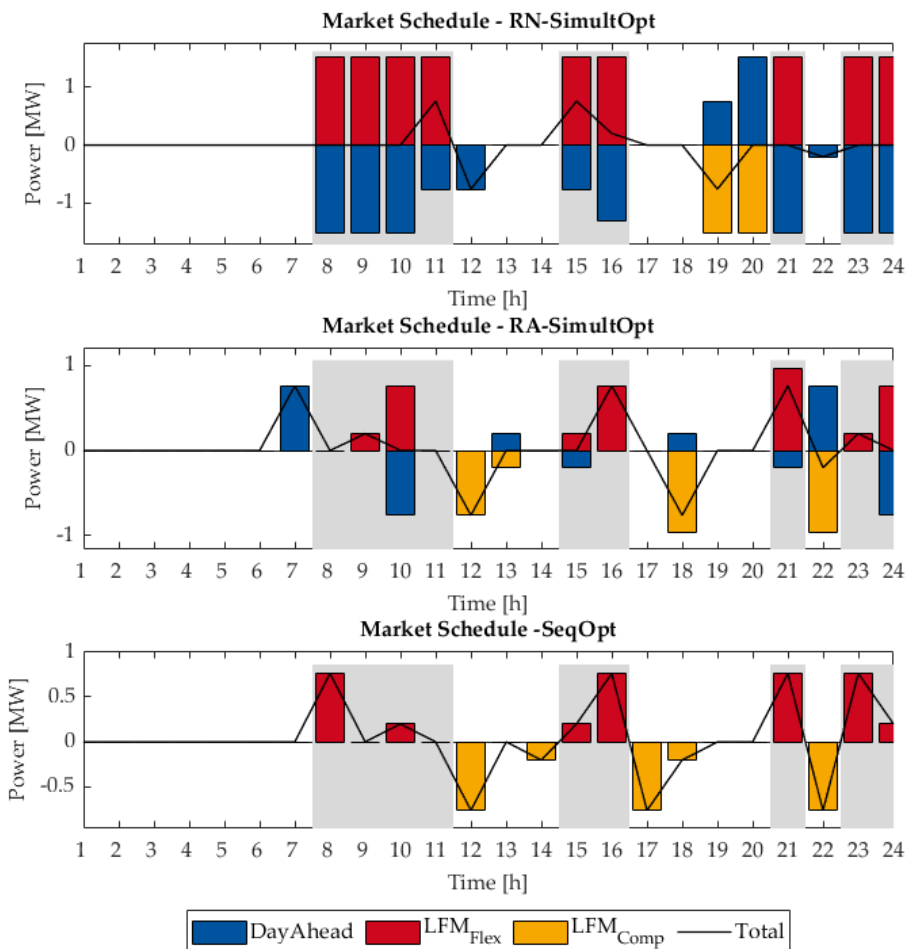
Figure 10. Market schedules of BSS for the three different operational planning modes (Congestion times shaded in